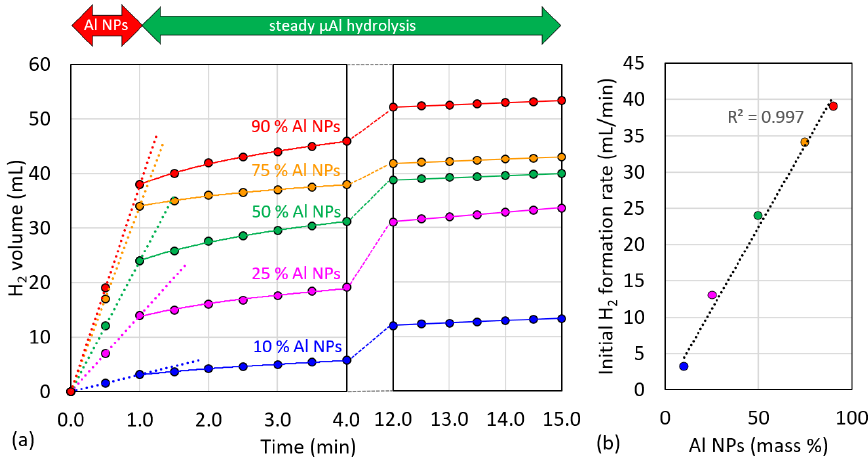
Figure 4. ( a ) Tracking of total H 2 gas volume formed by the hydrolysis of 50 mg- μ Al/Al NPs composite samples. ( b ) Dependence of initial H 2 formation rate on mass % of Al NPs.